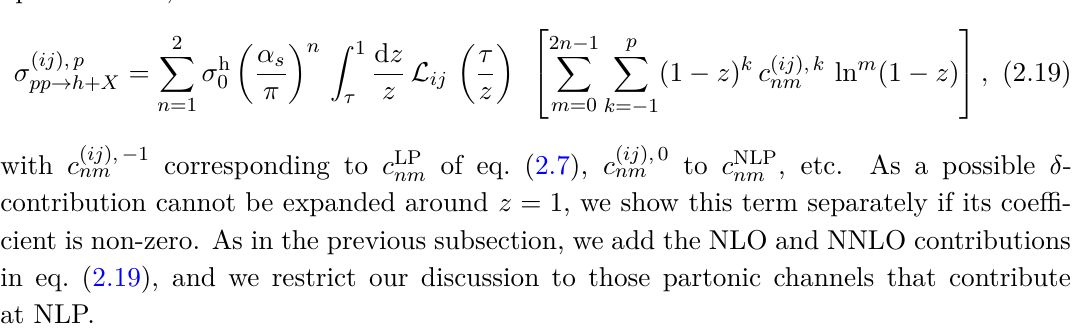
Figure 9. Same as figure 8, but for the total cross section of the DY production of an off-shell photon with Q = 125 GeV. The q ¯ q ( qg ) channel is shown on the left(right)-hand side. up to N p +1 LP, which follows